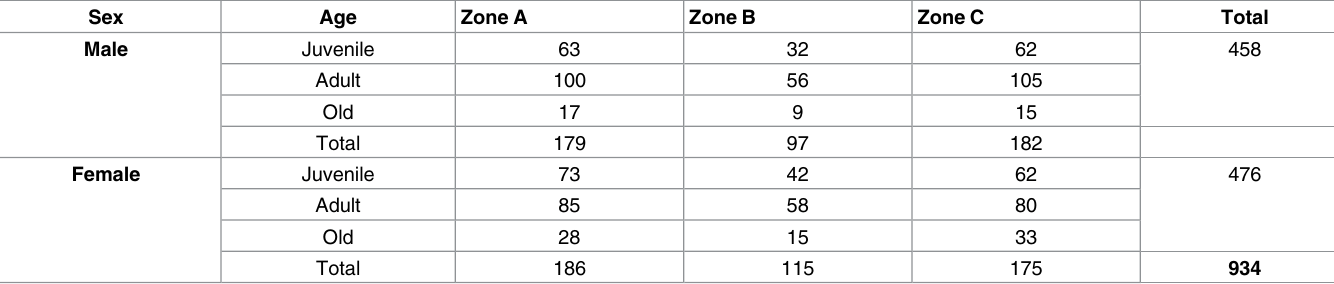
Table 1. Distribution of badgers enrolled in vaccine field trial by age, sex and zone of capture. Sex